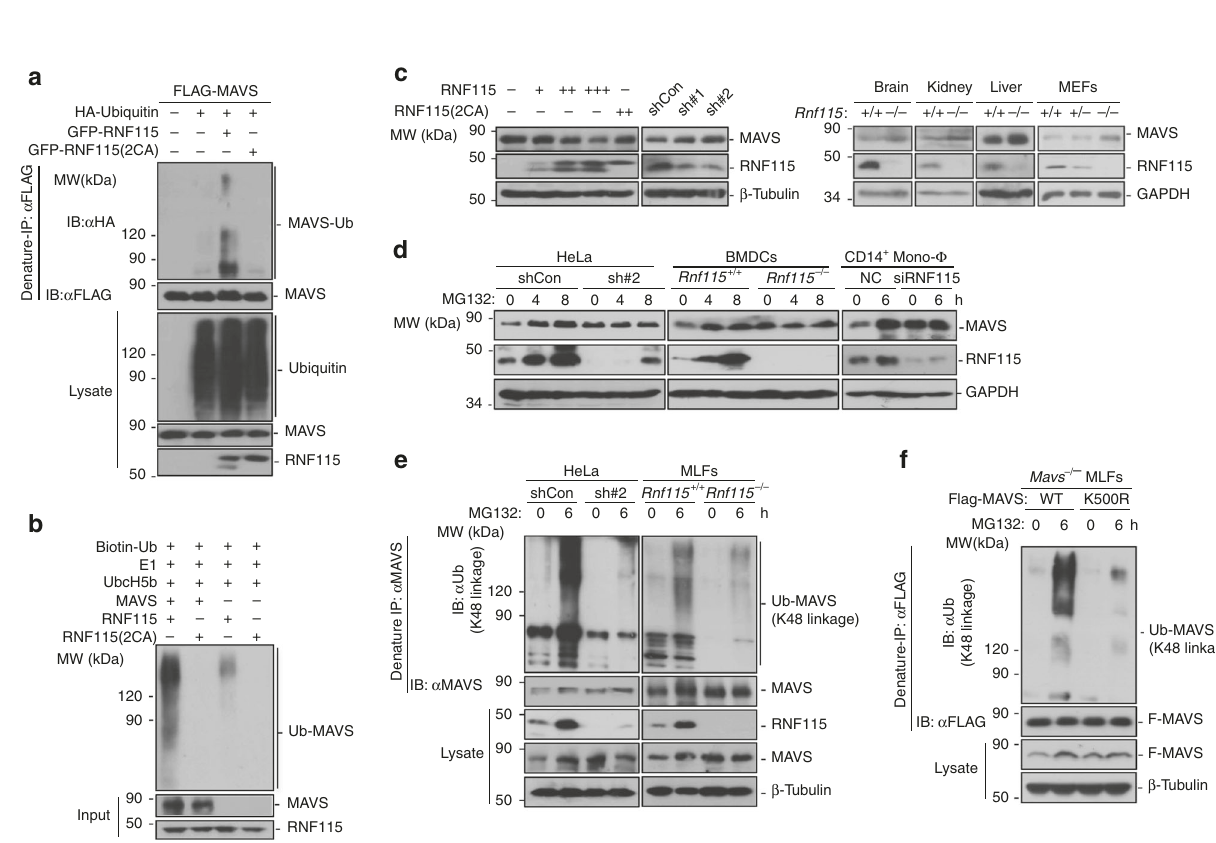
Fig. 5 RNF115 functions dependently on its enzyme activity. a, b qRT-PCR analysis of Ifnb , Ip10 , Infa4 , Isg56, or Rnf115 mRNA ( a ) or ELISA analysis of IFN- β and CCL5 ( b ) in Rnf115 − / − MLFs reconstituted with empty vector (Vec), RNF115, or RNF115(2CA) followed by infection with VSV for 0 – 6 h ( a ) or by infection with VSV or transfection of poly(I:C) for 12 h ( b ). c Immunoblot analysis of total and phosphorylated (p-)I κ B α , IRF3, and TBK1, and RNF115, RNF115 (2CA), or β -Tubulin in cells obtained in ( a ) infected with VSV for 0 – 8 h. d Fluorescent microscopy imaging of the replication of GFP-VSV in cells obtained in ( a ) infected with VSV-GFP (MOI = 0.5) for 24 h. e qRT-PCR analysis of VSV- N mRNA (left) or plaque assay of VSV replication in the supernatants of (right) cells obtained in ( a ) left uninfected or infected with VSV for 1 h followed by twice PBS wash and cultured in full medium for 24 or 48 h, respectively. f , g qRT-PCR analysis of Ifnb , Ip10 , Infa4 , Isg56 , or Rnf115 mRNA ( f ) or ELISA analysis of IFN- β , IL-6, and TNF ( g ) in cells obtained in ( a ) that were infected with HSV-1 or transfected with DNA90 for 0 – 8 h. h Immunoblot analysis of total and phosphorylated (p-)I κ B α , IRF3, and TBK1, and RNF115, RNF115(2CA), or β -Tubulin in cells obtained in ( a ) infected with HSV-1 for 0 – 8 h. i Flow cytometric analysis (left graphs) and microscopy imaging (right graphs) of the replication of H129-G4 in cells obtained in ( a ) infected with H129-G4 (MOI = 0.5). Numbers adjacent to the outlined areas indicate percentages of GFP + MLFs. j qRT-PCR analysis (upper graph) of UL30 mRNA and plaque assay (lower graph) analyzing HSV-1 titers in the supernatants of cells obtained in ( a ) infected with HSV-1 (MOI = 0.5) for 1 h followed by twice PBS wash and cultured with full medium for 24 h. * P < 0.05, ** P < 0.01, and *** P < 0.001 (two- way ANOVA). Scale bars represent 200 μ m. Data are representative of two independent experiments (graphs show mean ± SD in a , b , e , f , g , j ). Source data are provided as a Source Data fi le.